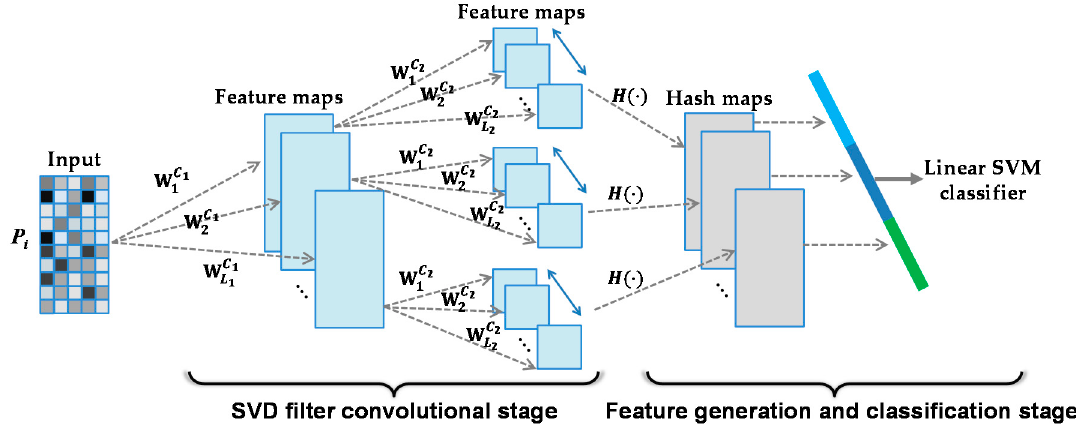
Figure 3. Detailed block diagram of singular value decomposition SVD networks.